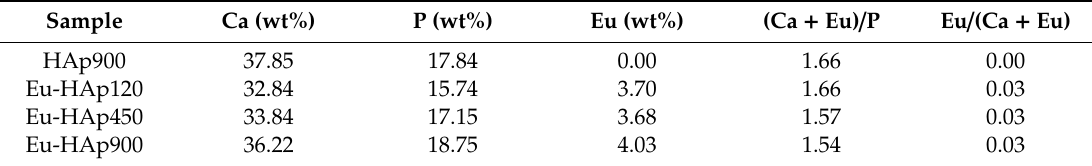
Table 1. Contents (wt%) and molar ratios of Ca, Eu and P for the synthesized hydroxyapatites (HAps), obtained by